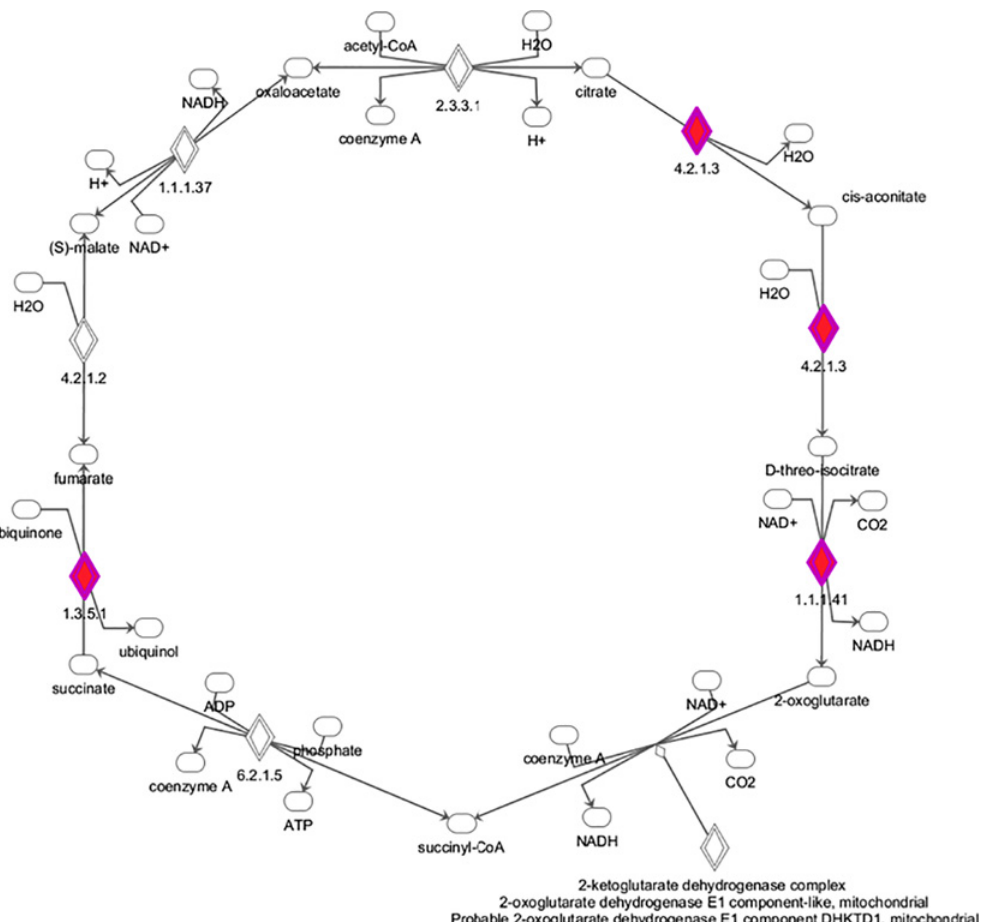
Fig 3. A graphical interpretation of the identified proteins in the reversed TCA cycle. Tricarboxylic acid cycle is depicted with marked proteins upregulated by exposure to 1% O 2 and 4% O. Glutamine enters the reversed TCA cycle as α -ketoglutarate and is subsequently processed to citrate and acetyl-CoA. Enzymes in metabolic pathways are shown as diamonds accompanied by enzyme nomenclature numbers , oval symbols represent substrates or products of metabolic reactions . Colored diamonds represent enzymes identified in proteomic analysis . 1 . 3 . 5 . 1 – Succinate dehydrogenase , 4 . 2 . 1 . 3 – Aconitate hydratase , 1 . 1 . 1 . 41 – Isocitrate dehydrogenase . "